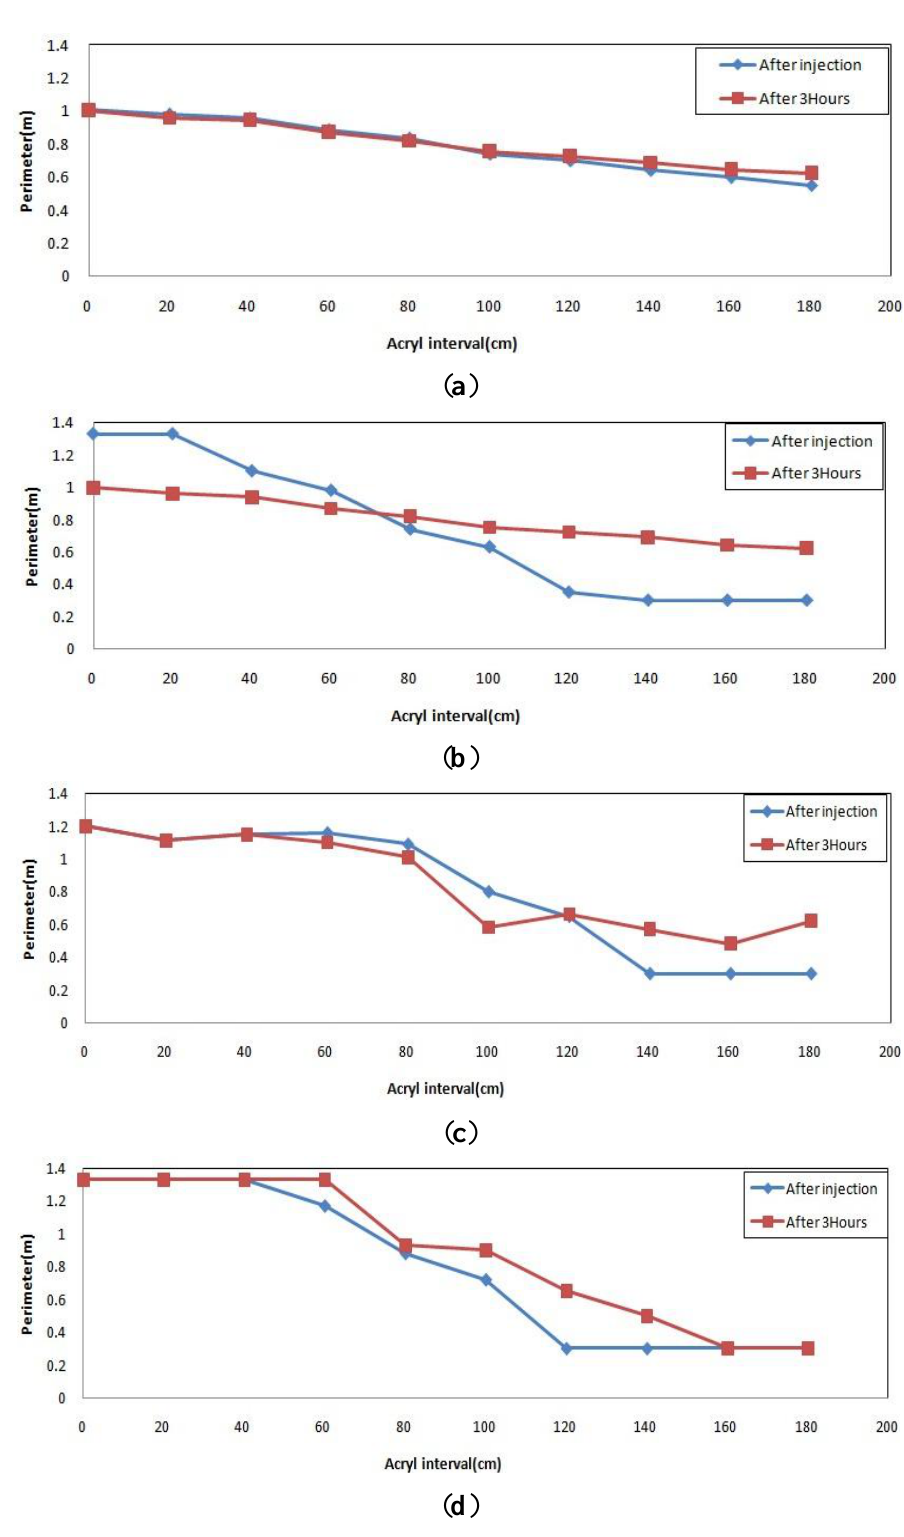
Figure 7. Injection pattern of general type material. ( a ) low viscosity (flow 0, injection 10); ( b ) low viscosity (flow 100, injection 10); ( c ) high viscosity (flow 0, injection 10); ( d ) high viscosity (flow 100, injection